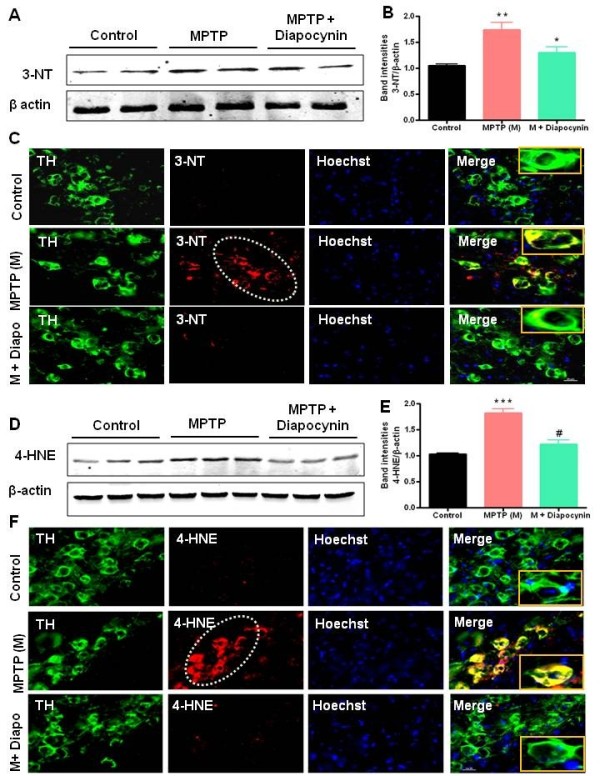
Diapocynin inhibits the formation of 3-nitrotyrosine (3-NT) and 4-hydroxynonenal (4-HNE) in the substantia nigra (SN) of MPTP-treated mice. (A) Representative Western blots illustrating the expression of 3-NT in SN. (B) Bar graph showing mean Western blot 3-NT/β-actin ratios ± SEM in SN of 6 mice per group. (C) Double labeling of tyrosine hydroxylase (TH) and 3-NT in SN region of ventral midbrain. (D) Representative Western blots illustrating the expression of 4-HNE in SN. (E) Bar graph showing mean Western blot 4-HNE/β-actin ratios ± SEM in SN of 6 mice per group. (F) Double labeling of TH and 4-HNE in SN region of ventral midbrain. Images were captured at 60× magnification. The SN zone is outlined in white dots. Inset pictures demonstrated colocalization of TH and 3-NT/4-HNE. ***P <0.001 vs the control group; **P <0.01 vs the control group; *P <0.05 vs the MPTP group; #P <0.001 vs the MPTP group.